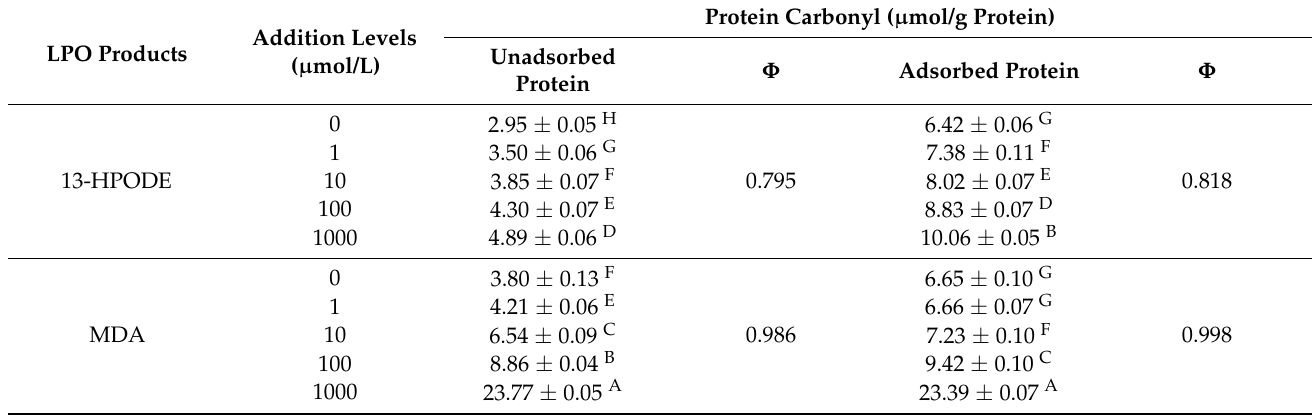
Table 4. Protein carbonyl of unadsorbed and adsorbed proteins extracted from the O/W emulsion oxidized by different levels of 13-HPODE or MDA for 48